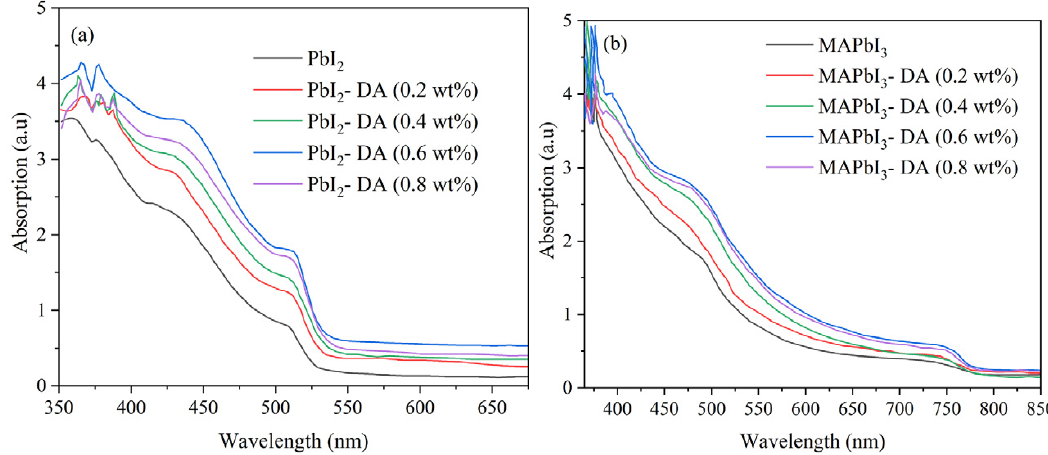
Fig. 3. UV-Visible absorption spectra of (a) PbI 2 films and (b) corresponding MAPbI 3 in presence of various concentration of DA.